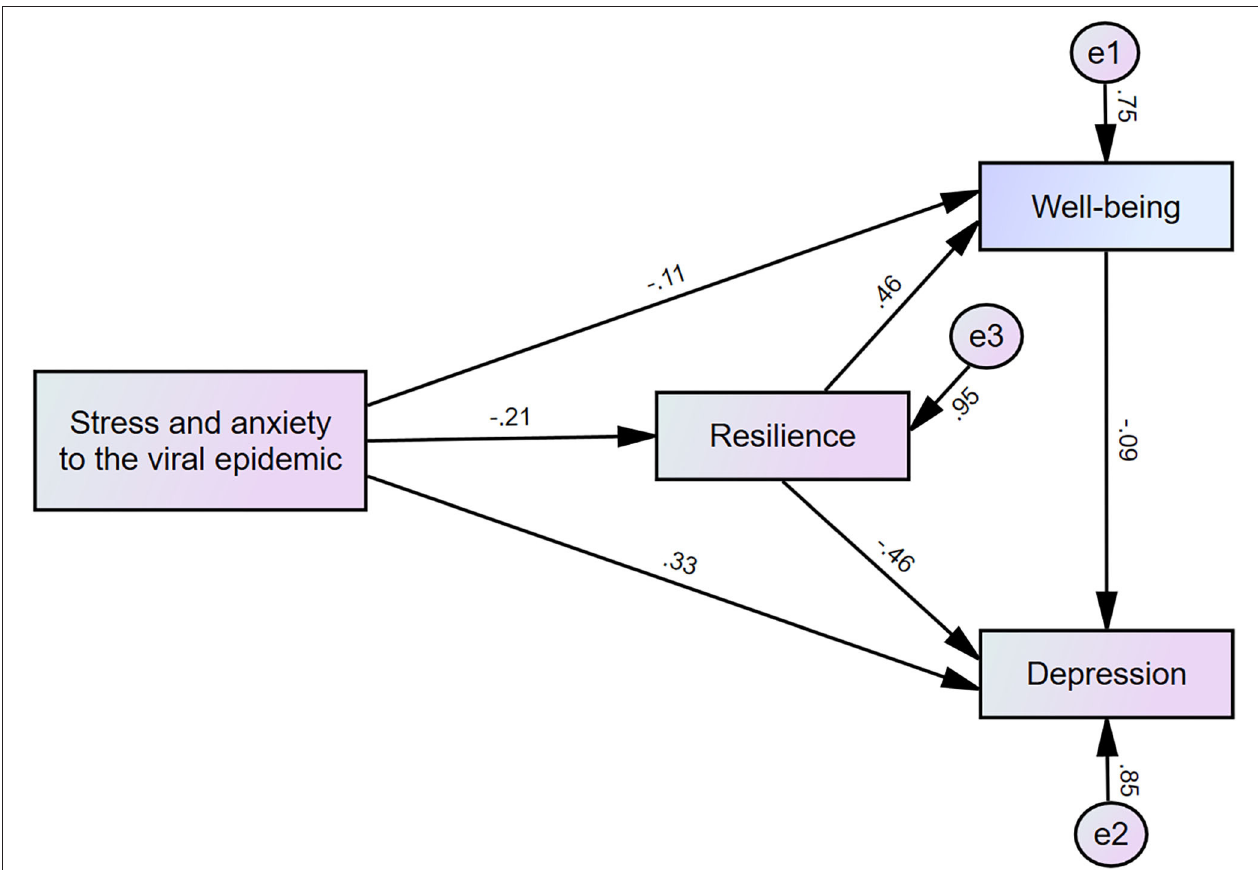
FIGURE 1 | Mediation model showing the pathway from the effect of stress and anxiety to the viral epidemic (independent variables) on psychological well-being or depression (outcome) through resilience